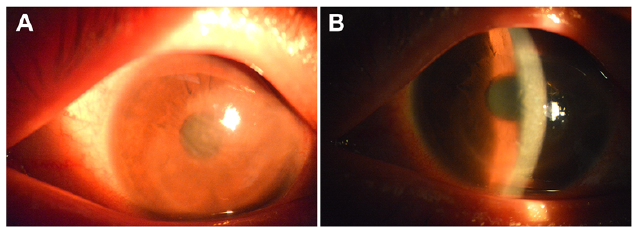
Figure 2. Varicella-zoster virus (VZV) corneal endothelitis following Coronavirus Disease 2019 (COVID-19) vaccination. ( A ) At presentation, the slit-lamp examination revealed diffused corneal edema associated with underlying Descemet’s fold and keratic precipitates. ( B ) The corneal edema was significantly reduced after a one-week topical and oral antiviral treatment.